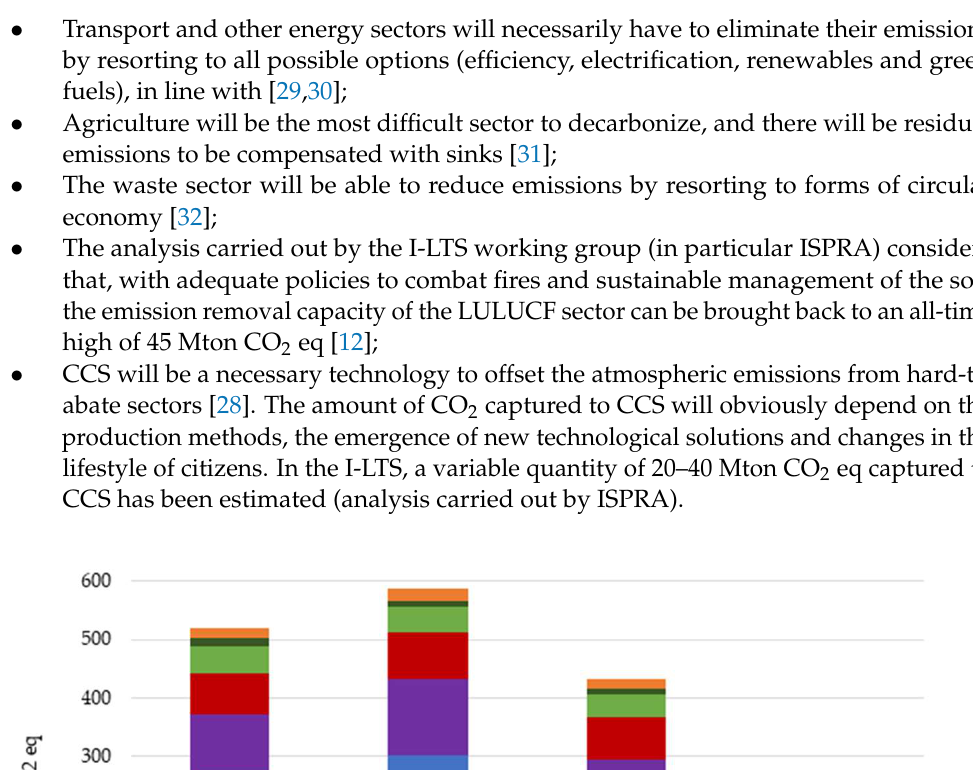
Figure 3. Main decarbonization options. To achieve climate neutrality by 2050, the system will have to resort to fundamental levers with strong synergies between them: